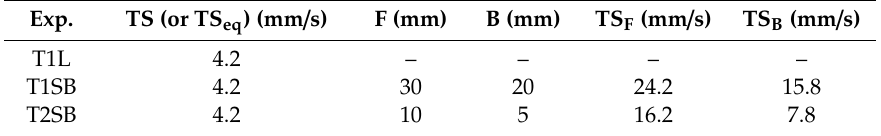
Table 4. Experimental planning (pulsed GMAW, 1.2 mm ER70S-6, CTWD of 18 mm, Ar + 5% O 2 and